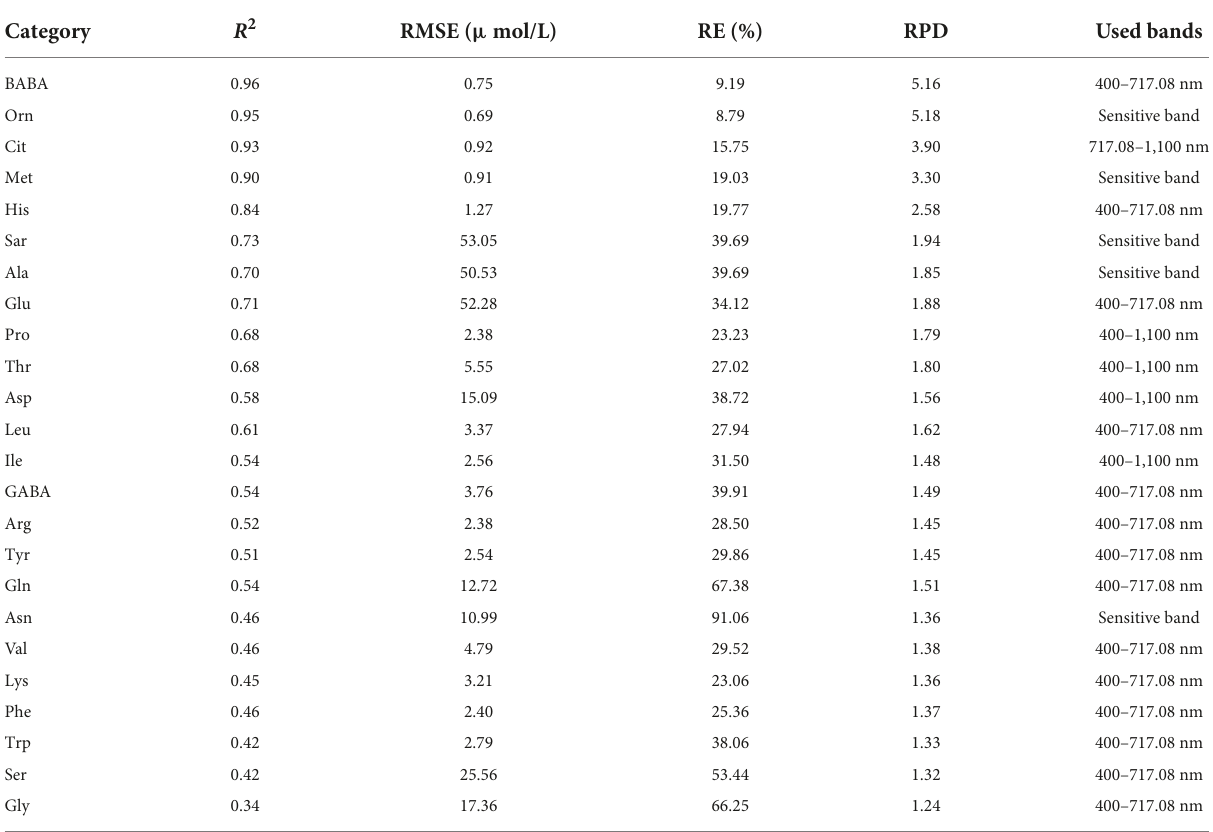
TABLE 5 Summary of optimal estimate results of each amino acid content using the test